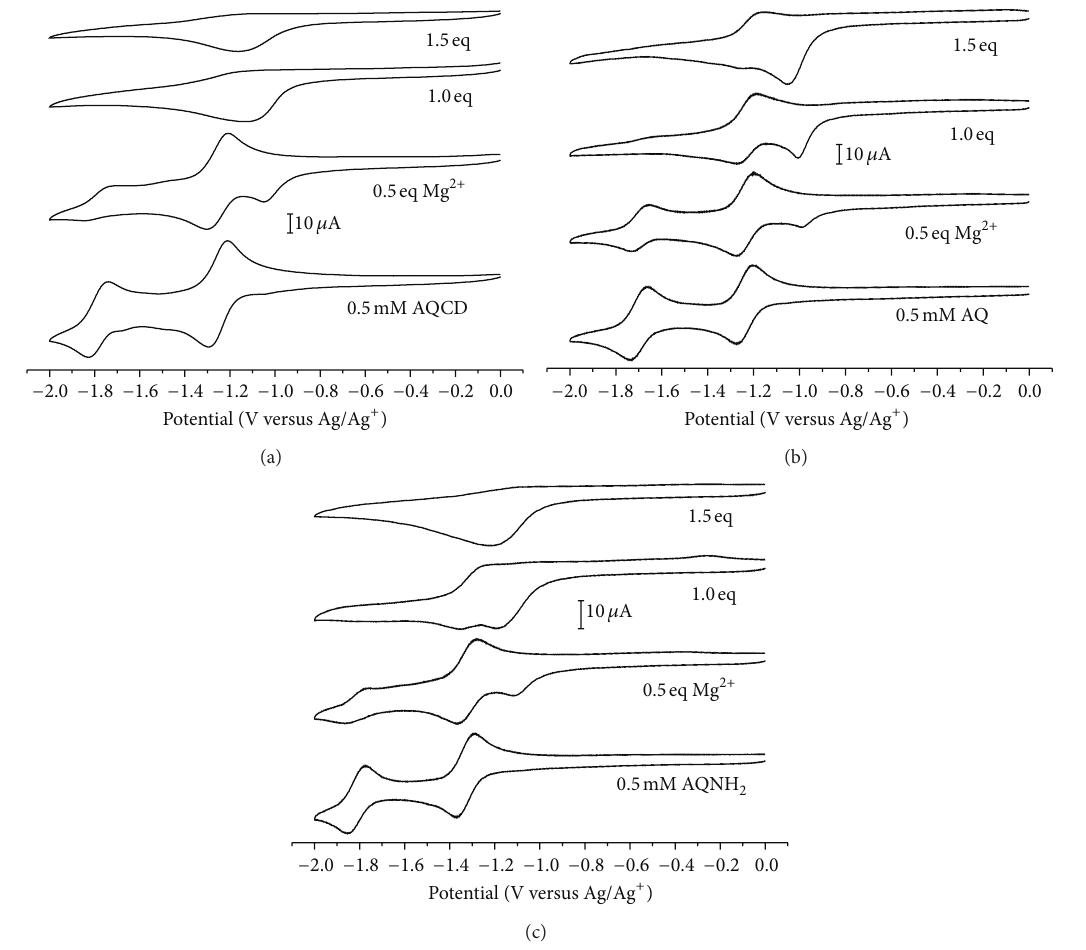
Figure 4: CVs of 0.5 mM (a) AQCD, (b) AQ, and (c) AQNH 2 in the absence and presence of 0.25, 0.5, and 0.75 mM Mg 2+ in 0.1M TBAPF 6 / CH 3 CN. Scan rate: 50